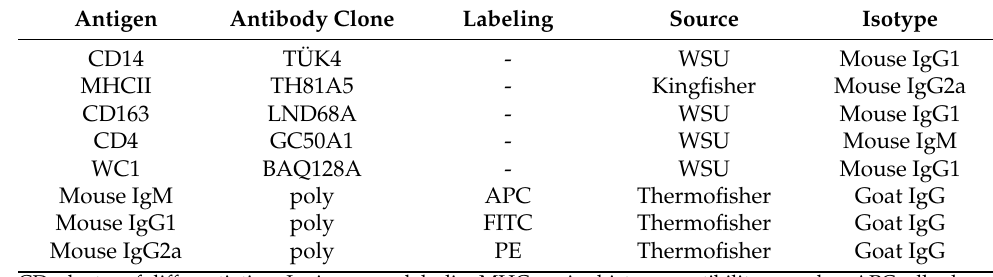
Table 1. List of